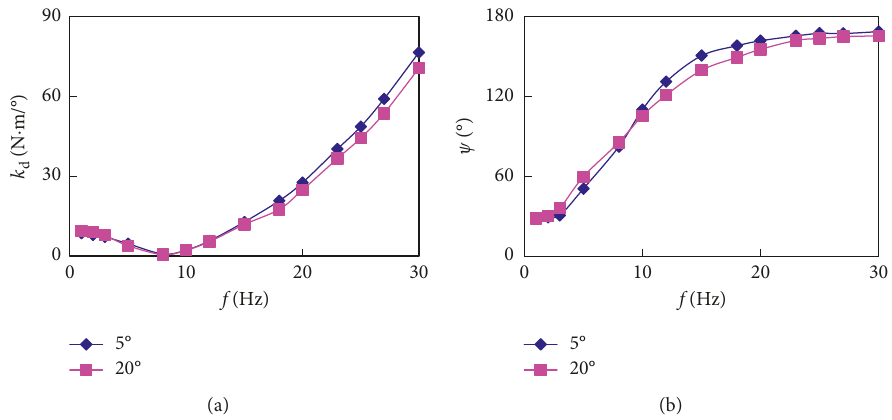
Figure 21: Different pretwisted angles at θ